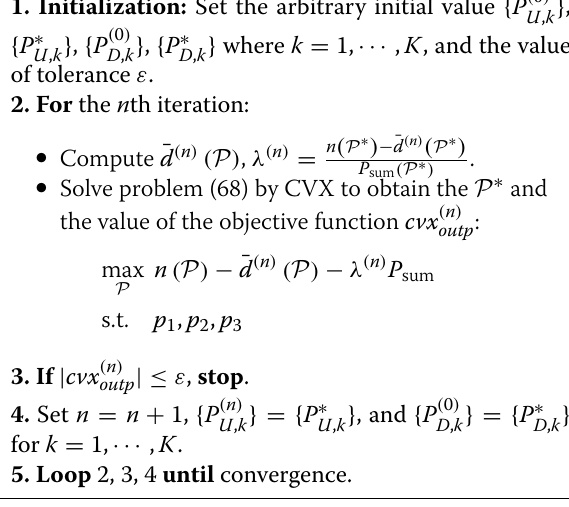
Algorithm 2 Solving problem (59) by CVX